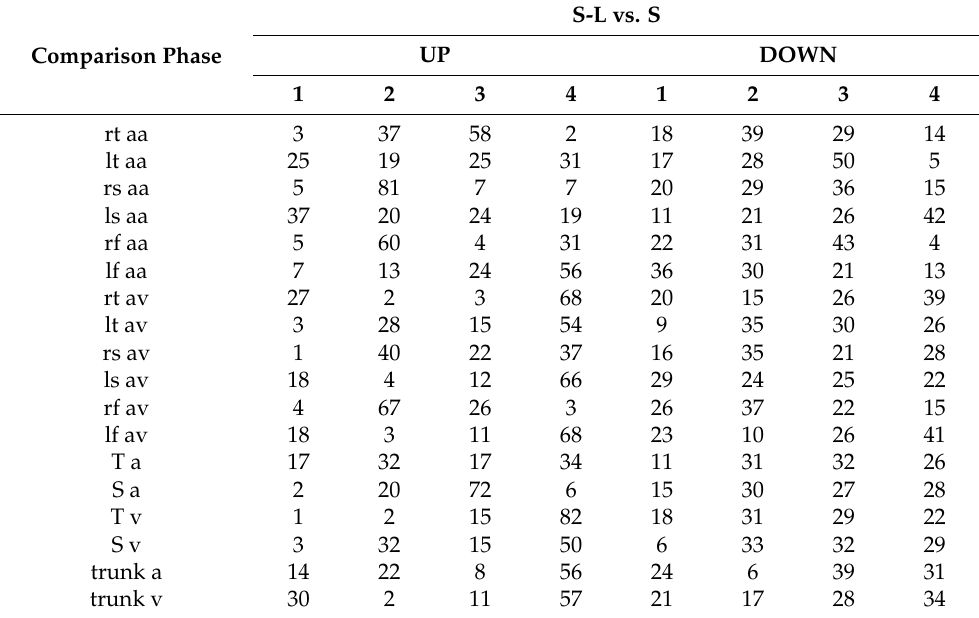
Table 5. Percentage of the significant difference points in each gait phase of each parameter (%).